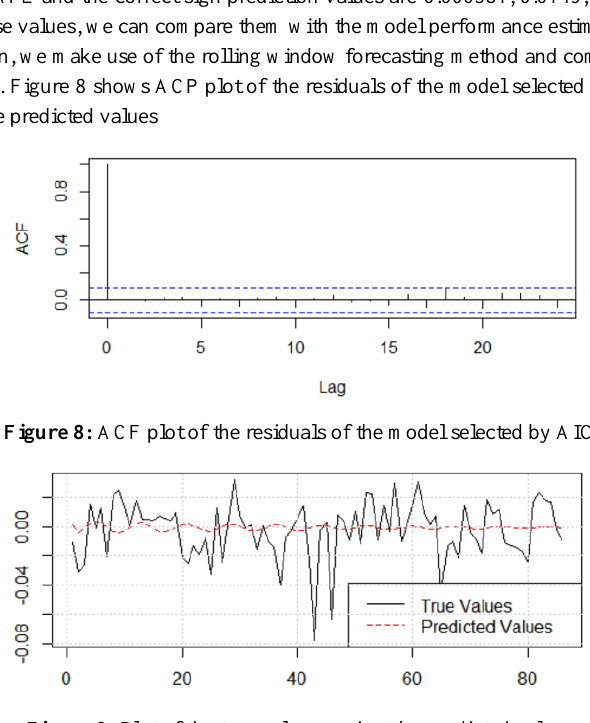
Figure 9: Plot of the true values against the predicted